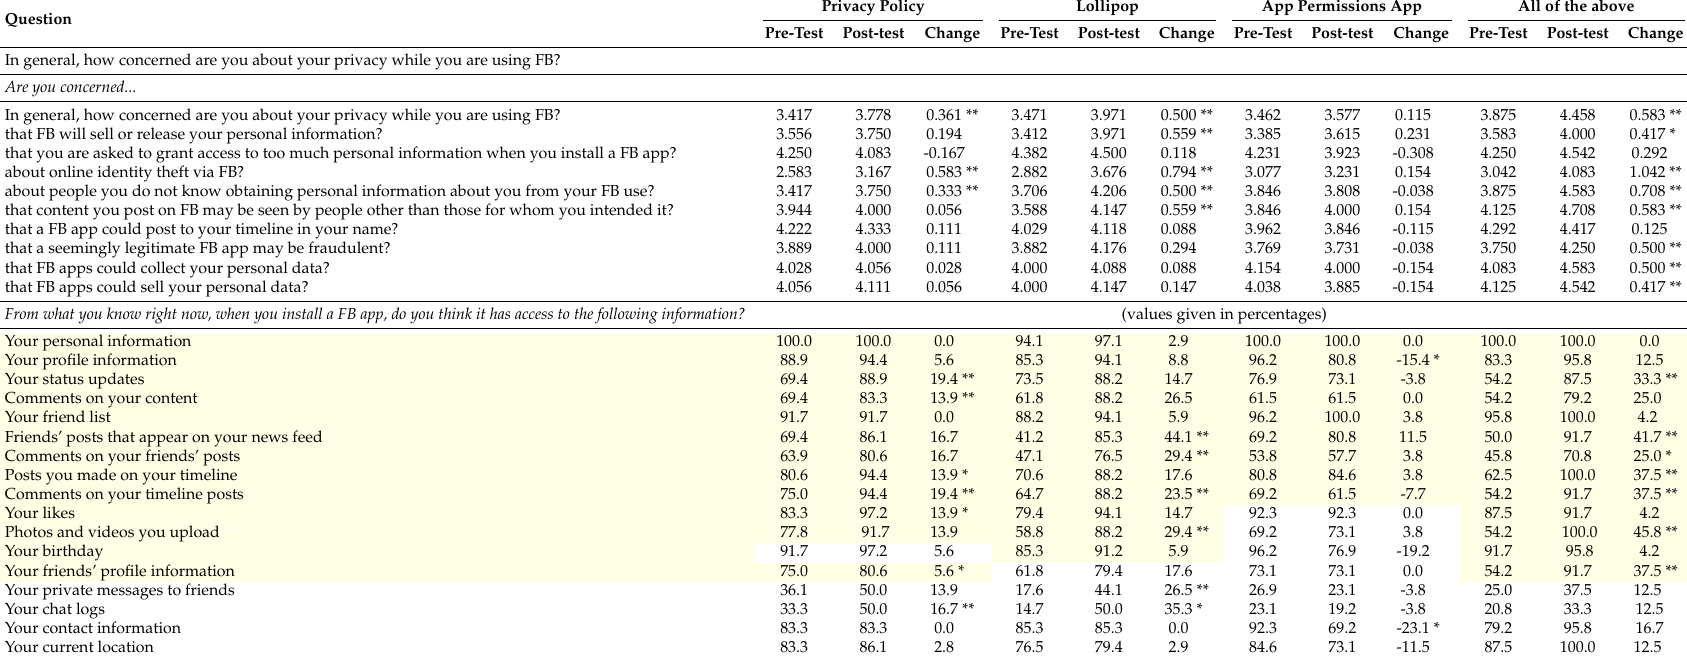
Table 5. Answers to survey questions pre- and post-test grouped by condition. Significant changes from pre- to post-test are shown with * for p < 0.05 and ** for p < 0.01. When a condition indicates that a particular data point can be accessed by an app, it is highlighted in